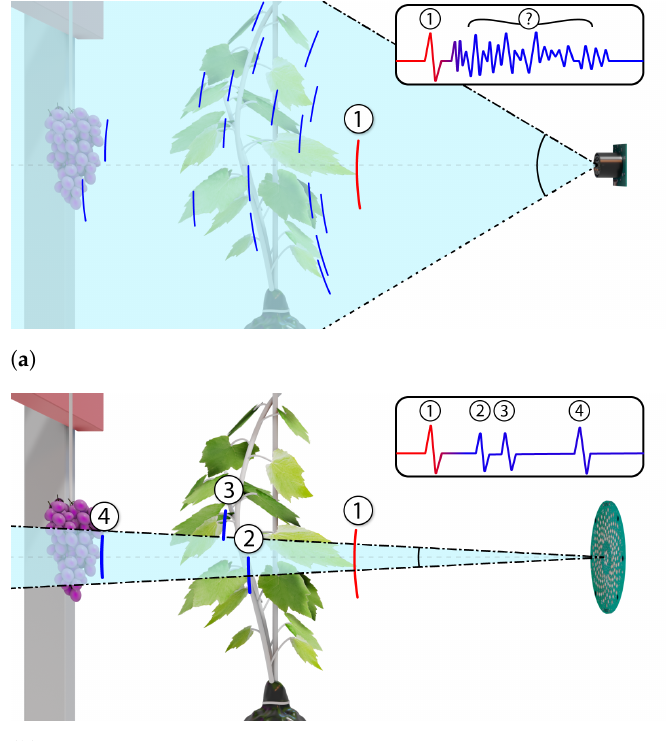
Figure 1. A single ultrasonic transducer (not an array) with a wide beamwidth can struggle to image objects behind the front leaves, as illustrates in diagram ( a ). In contrast, diagram ( b ) illustrates how an ultrasonic array such as used in this work (see Figure 2 for a photo) with a narrow beamwidth can provide improved ability to image at multiple depths behind the front leaves.